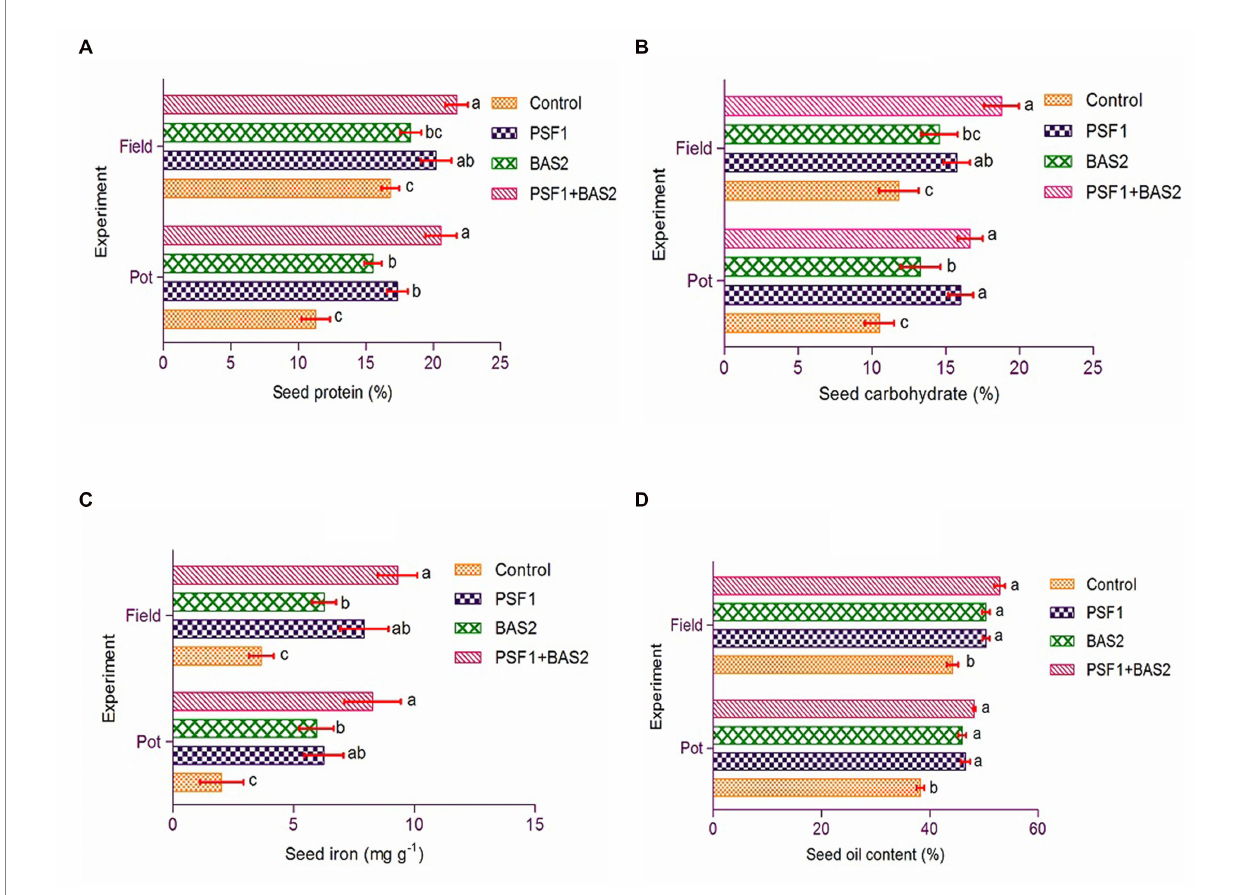
FIGURE 7 Effect of PGPR biostimulants Pseudomonas fluorescens (PSF1) and Bacillus subtilis (BAS2) on seed nutrients (A) protein; (B) carbohydrate; (C) iron; and (D) oil content. Error bar represents standard deviation ( n = 3). Small alphabetical letters above the error bar indicate significant difference between treatments according to Tukey’s post-hoc test ( p ≤ 0.05).